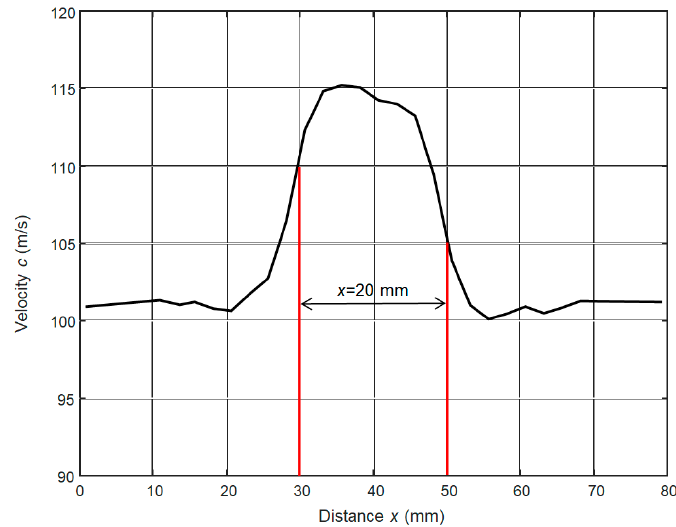
Figure 8. Mean value of the A 0 mode velocity versus distance x Figure 9. Mean value of the A 0 mode velocity versus distance x.